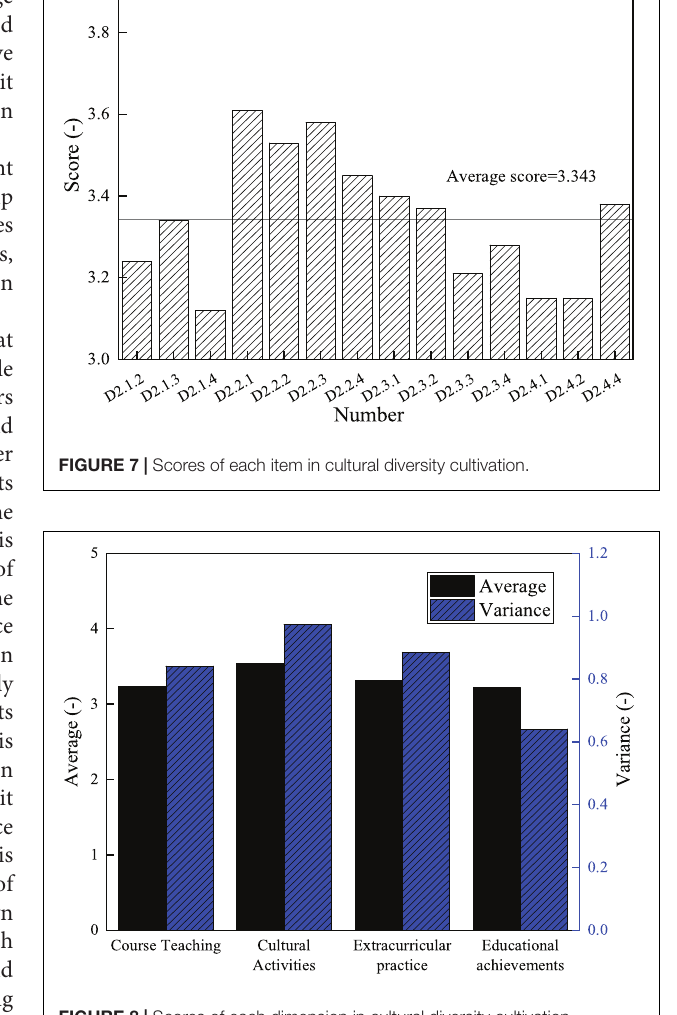
FIGURE 8 | Scores of each dimension in cultural diversity